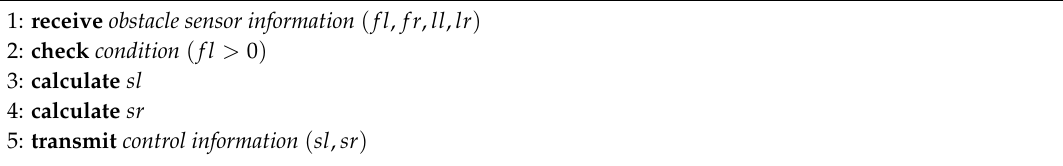
Algorithm A4 Pseudocode of the FW algorithm in the